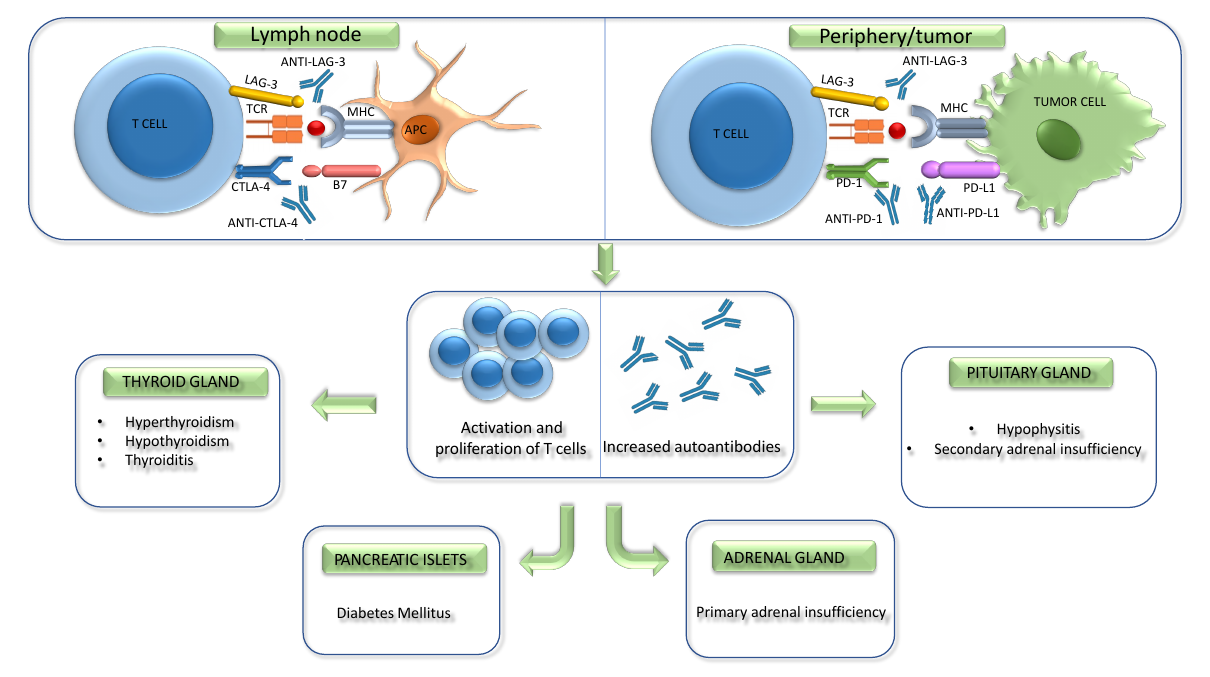
Figure 1. Role of immune checkpoints in antitumor immune responses and endocrine adverse events, induced by immune checkpoint inhibitors. CTLA-4 competes with CD80/CD86 to prevent excessive T-cell activation, while the activation of the PD-1/PD-L1 axis keeps T-cell in an anergic state. Furthermore, LAG-3 interacts with MHC, upregulating the function of T-cells and downregulating TCR signal transduction. Inhibition of these immune checkpoints induced by ICIs prevents inhibition signals, and recognizes T-cells to kill cancer cells. On the other hand, this process can also lead to a reduced self-tolerance against other tissues, thus favoring autoimmune events, including endocrine ones, at different levels. APC: antigen-presenting cell; B7: CD80/CD86; CTLA-4: cytotoxic T-